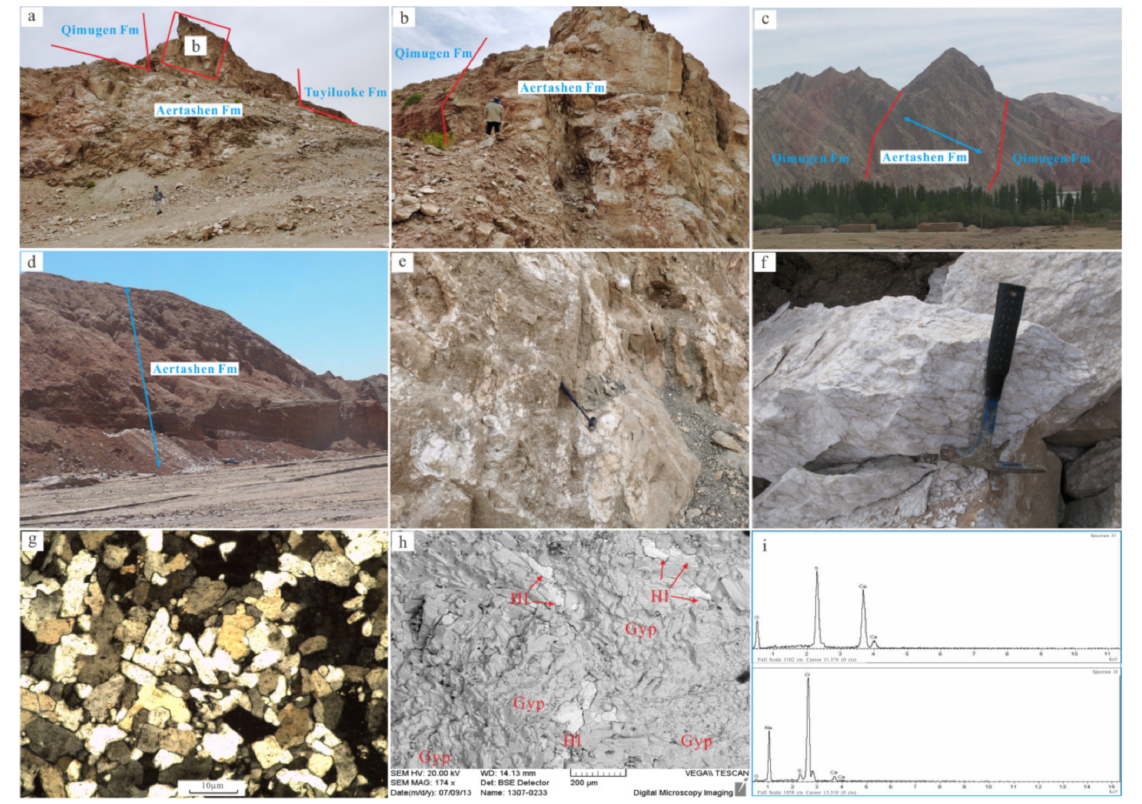
Figure 2. Three main marine sulfate outcrops and mineral characteristics of gypsum in KLY outcrop in the Yarkand Basin (Gyp: Gypsum. Hl: Halite). ( a ) Keliyang (marked by KLY) gypsum outcrop with underlying Tuyiluoke formation (Late Cretaceous) and overlying Qimugen formation (early Eocene); ( b ) photograph of part of the panel a ; ( c ) Aertashen (marked by AET) gypsum outcrop; ( d ) Dashankou (marked by DSK) gypsum outcrop; ( e ) gypsum of KLY outcrop; ( f ) gypsum of AET outcrop; ( g ) gypsum of KLY sample; ( h ) SEM image of KLY sample with grey white halite in the gypsum; ( i ) EDS spectrum